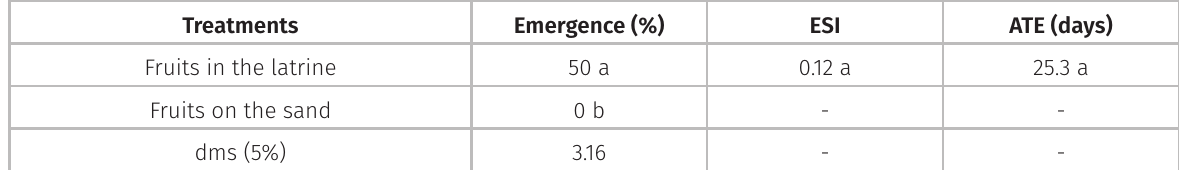
*Averages in the same column followed by the same letter do not significantly differ by the Tukey test (p < 0.05). dms: value of the least significant difference for the chosen